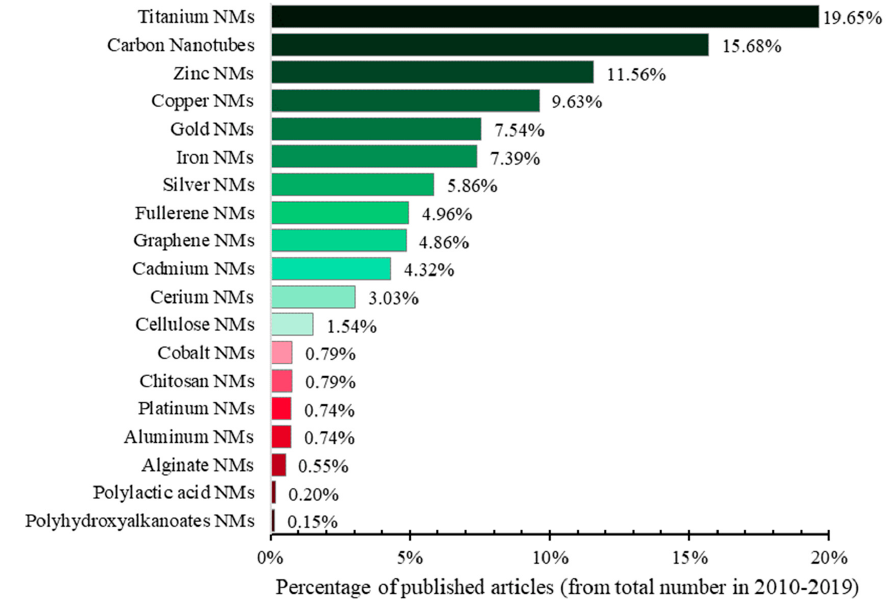
Figure 18. Bibliometric analysis of research on ecotoxicity of various types of nanomaterials in 2010–2019 from Web of Science Core Collection (Web of Science, Clarivate Analytics), the search strategy used to retrieve the data being: sum of the codes for NMs from each category (metallic NMs: aluminum, cadmium, cerium, cobalt, copper, gold, iron, platinum, silver, titanium and zinc; inorganic carbon NMs: carbon nanotubes, fullerene and graphene; organic carbon NMs: alginate, cellulose, chitosan, polyhydroxyalkanoates and polylactic acid).